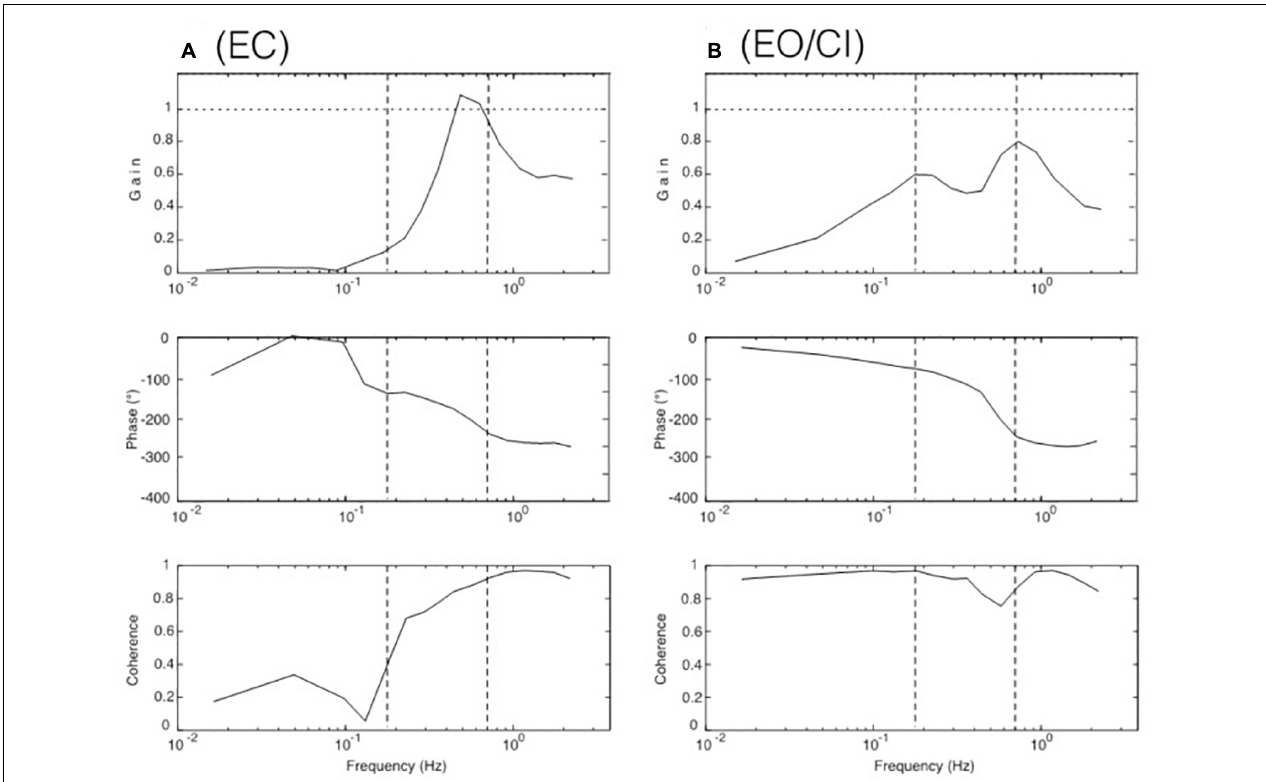
FIGURE 6 | Robot simulation results for COM balancing without vision ( A , EC for “eyes closes”) and with visual input corresponding to the continuous illumination condition ( B ,